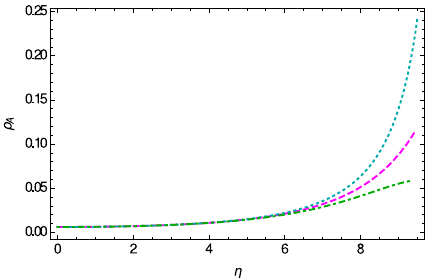
Fig. 13 Variation of ¯ ρ A for three-form field photon stars as function of η ,for ¯ a = 0 . 007andthreedifferentvaluesoftheconstant ¯ b ,andforthree different values of the constant ¯ b : ¯ b = 0 (dashed curve), ¯ b = − 0 . 11 (dotted curve), and ¯ b = 0 . 11 (dot-dashed curve), respectively. The central density of the photon star is ρ mc = 7 . 12 × 10 14 g / cm 3 , while ¯ ζ = 0 and ¯ ζ (cid:13) = 7 × 10 − 3 , respectively 0 0